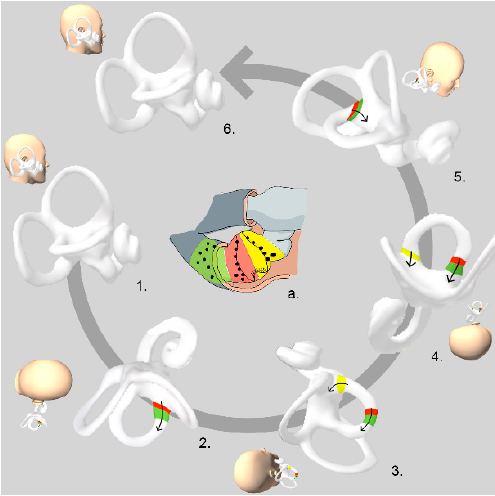
Figure 2. Zuma e Maia maneuver: right apogeotropic variant of HSC-BPPV: Figure a: detail of horizontal canal ampulla. Red area: otoconia attached to the cupula facing the canal (C-Cup). Green area: free-floating otoconia in the anterior arm (anterior arm canalolithiasis ). Yellow area: otoconia attached to the cupula facing the utricule (U-Cup)